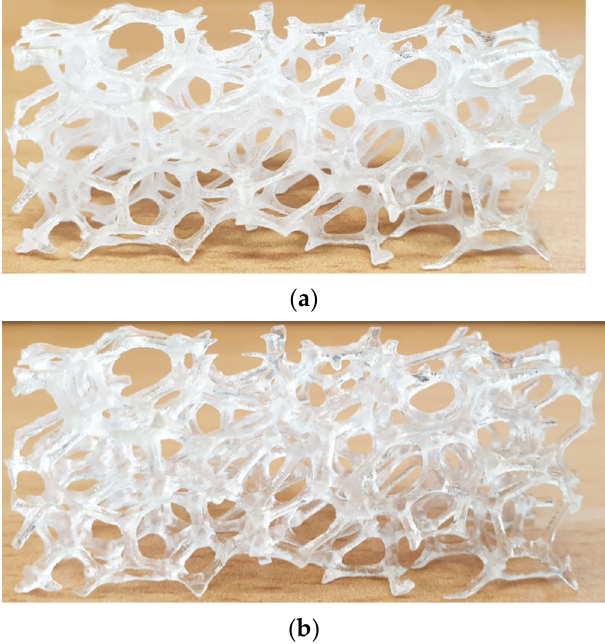
Figure 1. 3D printed transparent replica of metal foam ( a ) before and ( b ) after post-processing for refractive index matching.